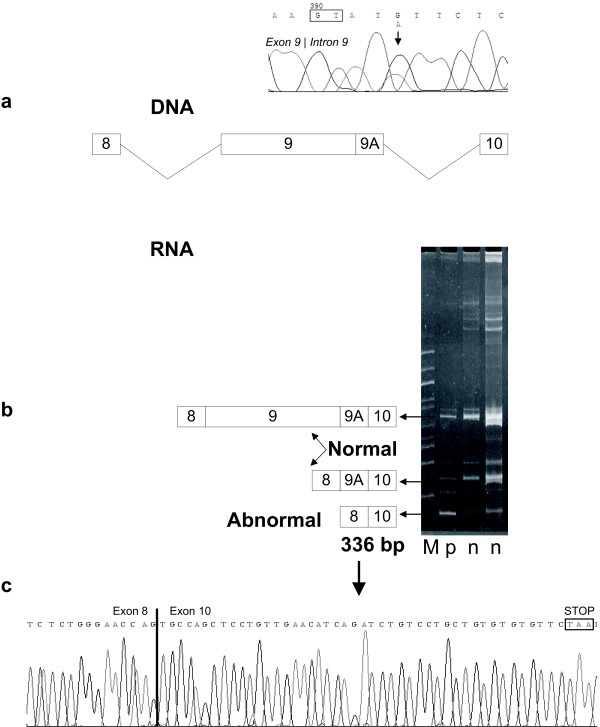
A. DNA sequence chromatogram at the splice junction between exon 9 and intron 9. Donor site is in a box and IVS9+5G>A mutation is indicated by an arrow. Genomic structure from the region including exons 8 and 10 with exons in boxes and introns printed as broken lines. B. The two normal splice variants 9 (exons 8-9-9A-10), 9A (exons 8-9A-10) and the abnormal variant missing exon 9 (exons 8–10). RT-PCR products on 6% PAGE are indicated by horizontal arrows. M: 100 bp DNA Ladder (New England Biolabs), p: patient sample and n: normal samples. The 336 bp abnormal product is quite evident in the patient sample. C. Chromatogram showing sequence of the abnormal transcript. Vertical line in chromatogram showing the abnormal junction between exons 8 and 10 while the box indicates the STOP signal created by the frameshift.